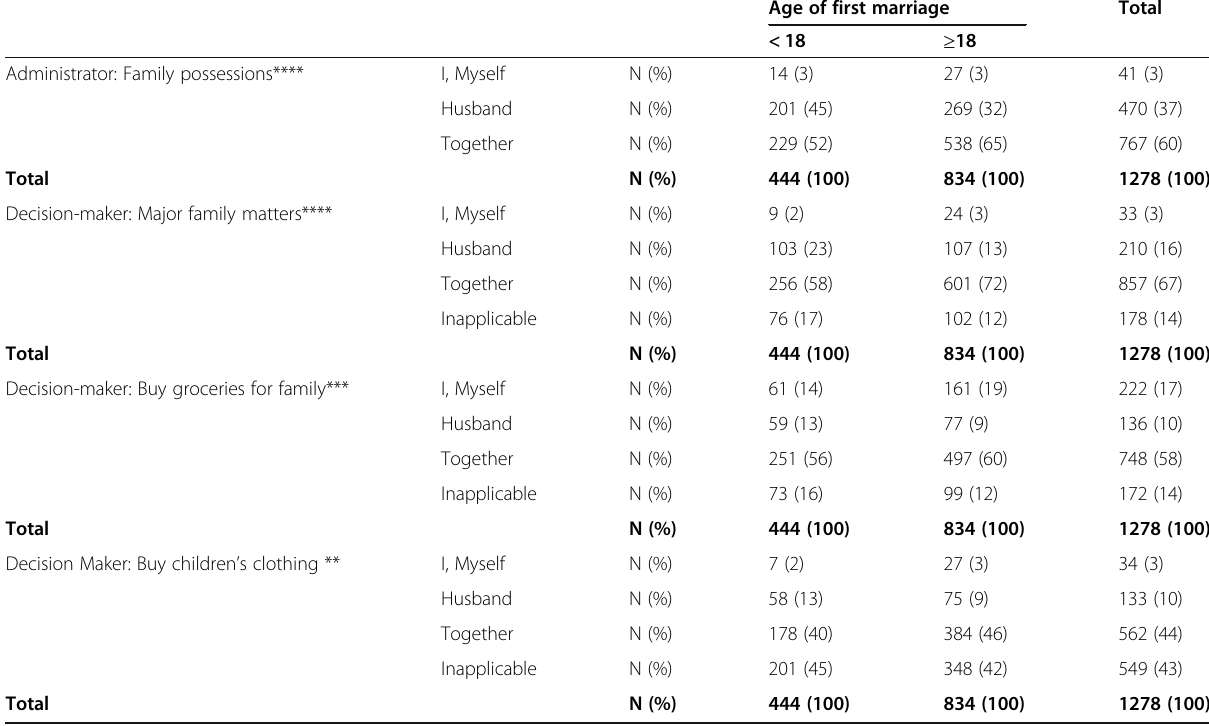
Table 3 Decision-making and administration of household affairs by age at first